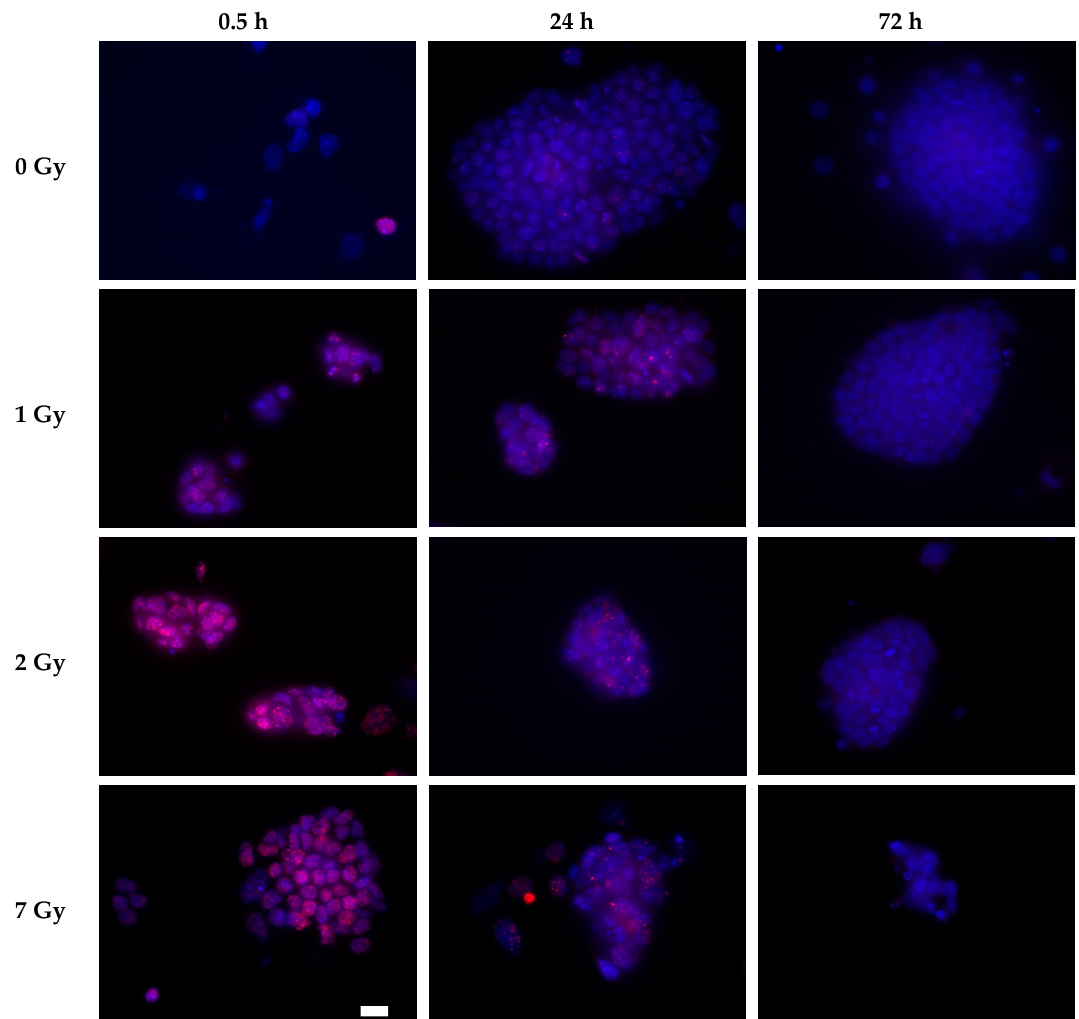
Figure 6. γ H2AX foci in mESCs after exposure to X-rays in the presence of LIF. Cells were seeded on cover slips, grown for one day and exposed to X-rays. Cells were fixed with 3.5% formaldehyde at the indicated time points. Immunofluorescence staining was performed using a γ H2AX antibody (pink foci), and cell nuclei were stained with DAPI (blue). Scale bar (white box) 20 μ m.